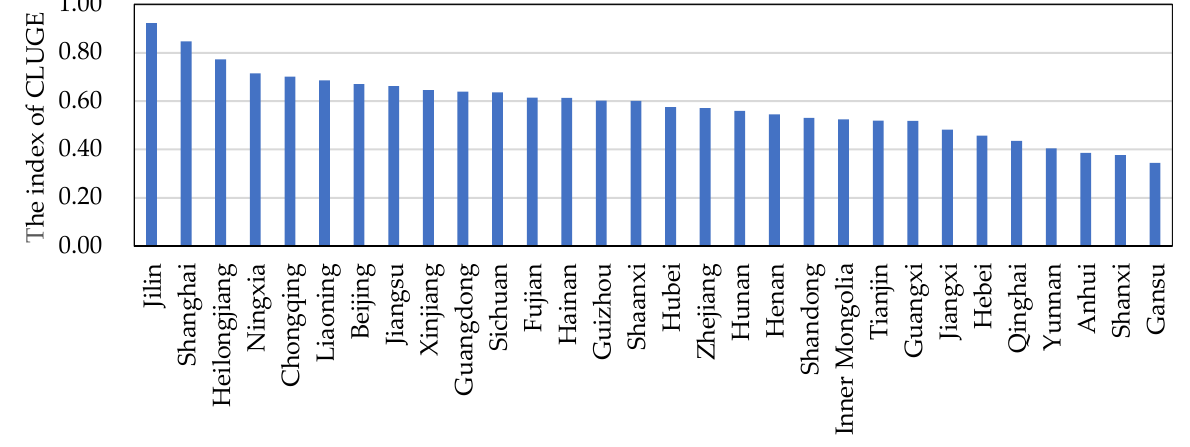
Figure 4. The average GUECL in 30 provinces in the PRC from 2005 to 2019.